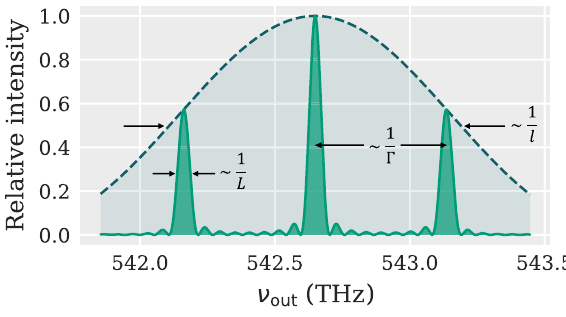
FIG. 8. Simulation of the phase-matching intensity showing how the spectral features are related to the superpoling param-